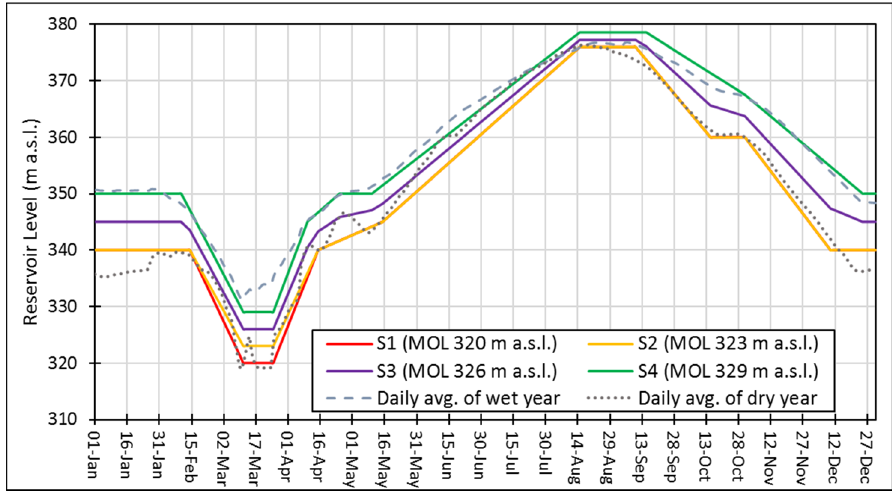
Figure 8. Future reservoir operation curves.